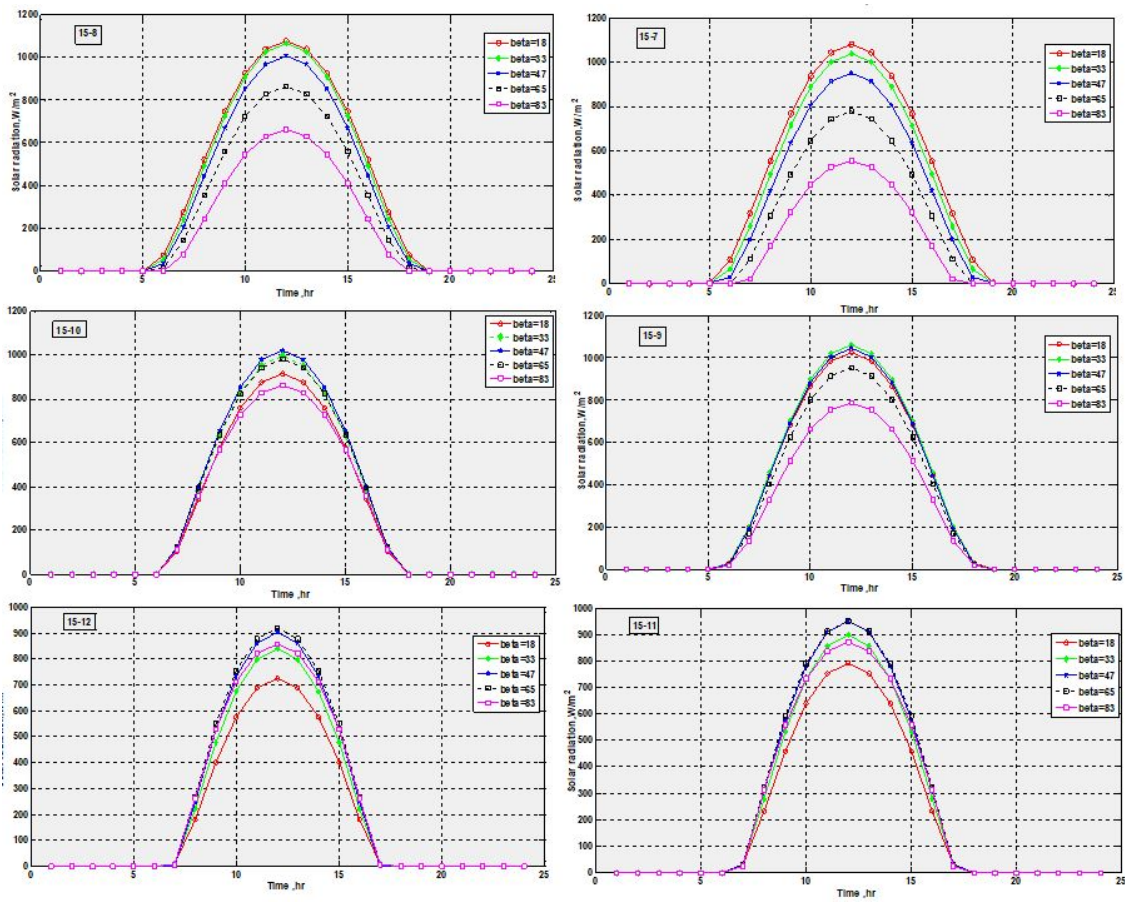
Figure 7. Variation of tilt angle through the months of year